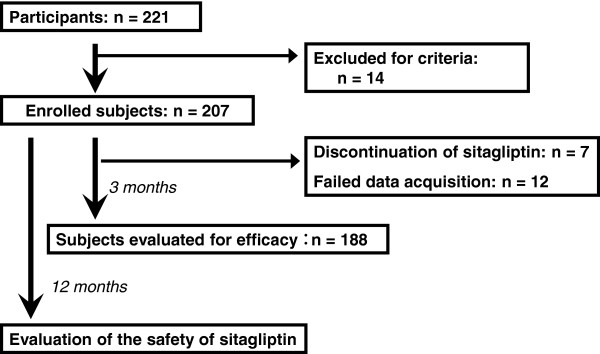
Study Enrollment.